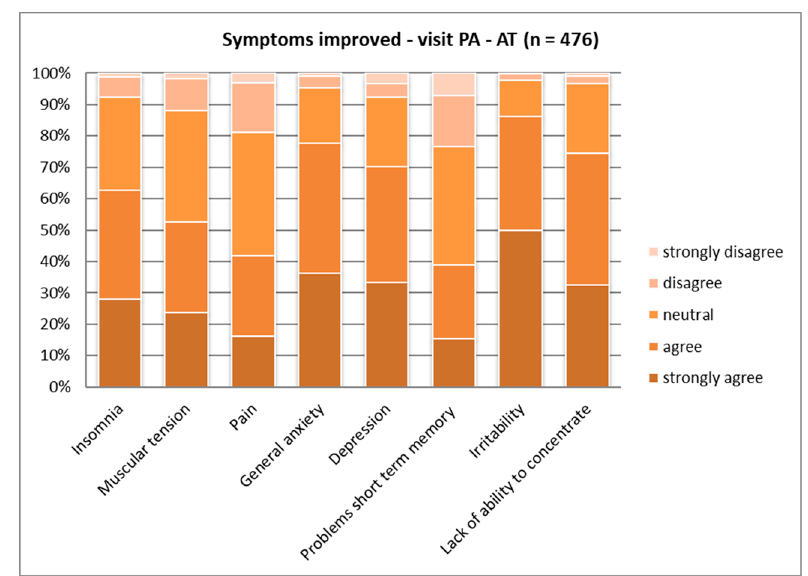
Figure 7. Symptoms improved by PA visitation—Austria ( p ≤ 0.01).